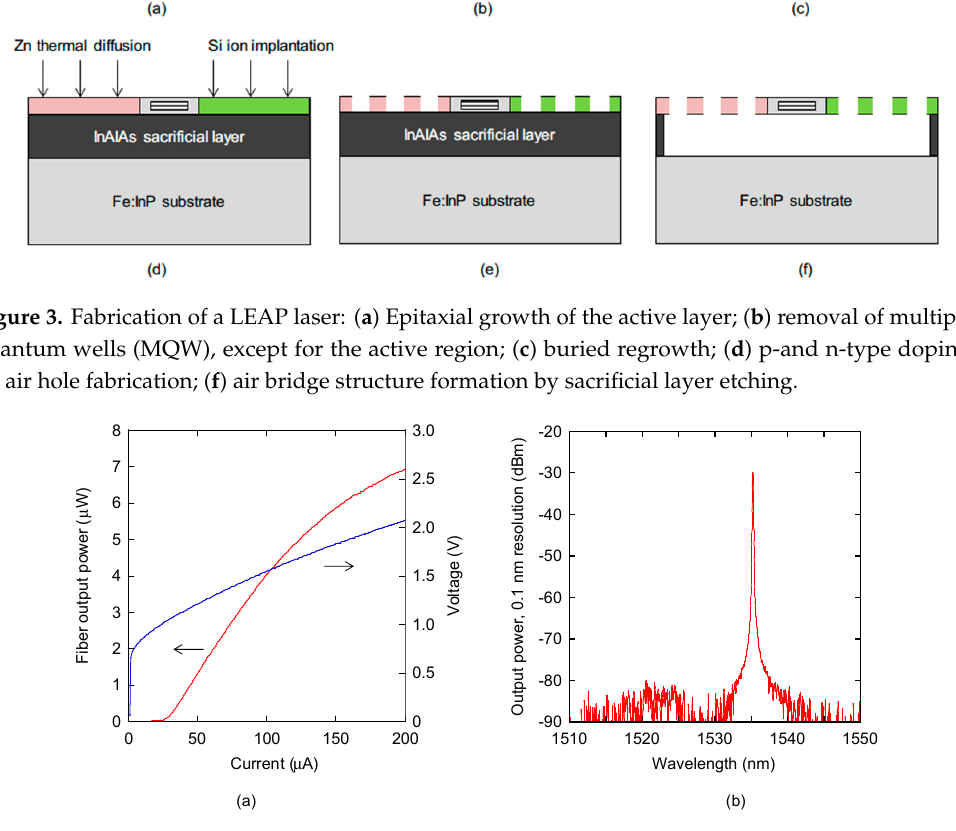
Figure 4. Static characteristics of a LEAP laser on InP substrate: ( a ) current–light output (red) and current–voltage (blue) characteristics under room-temperature continuous-wave (RT-CW) conditions; ( b ) lasing spectrum at a bias current of 100 μ A.